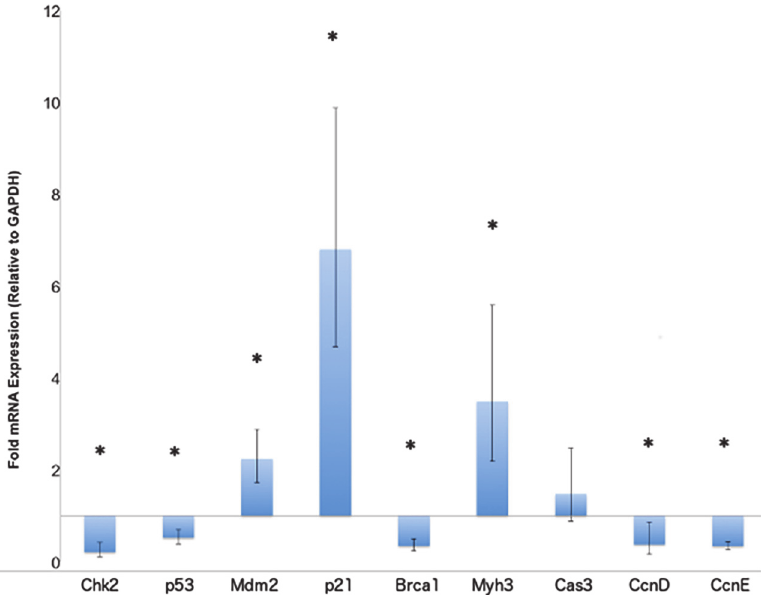
Fig 2. qRT-PCR confirmation of gene expression changes related to cell cycle regulation. qRT-PCR was performed on mRNA isolated from quadriceps muscle of Cfl2 KO mice and compared to wild-type littermates. GAPDH was used as a control. Fold changes are plotted, with standard deviation indicated by error bars. Asterisks indicate significant differences (p-value < 0.05) between